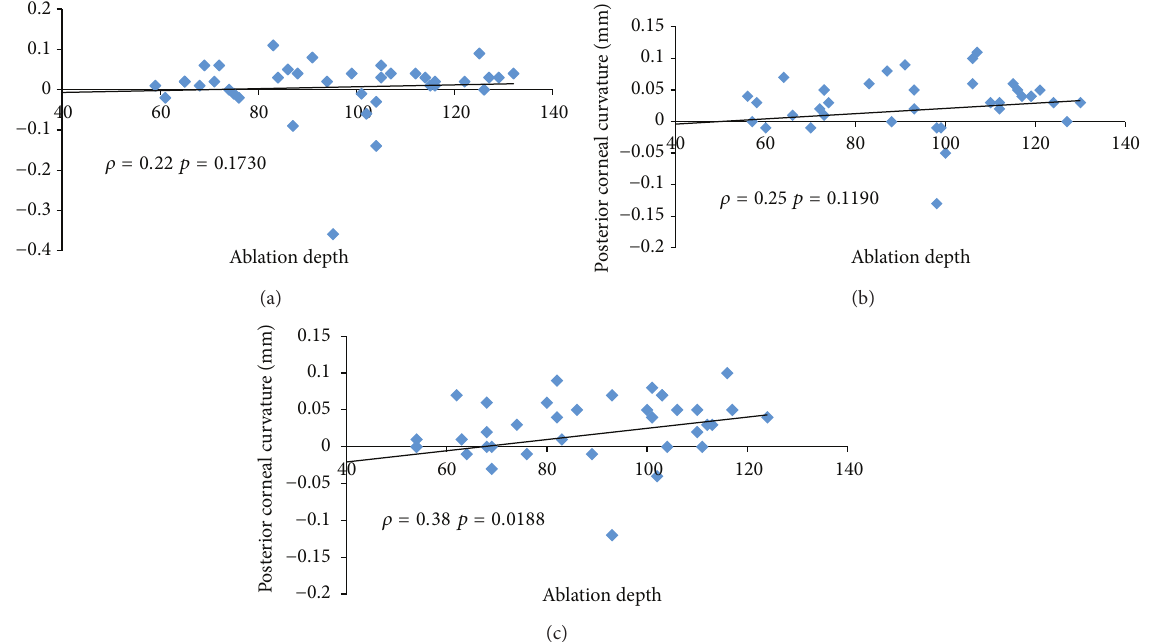
Figure 1: Spearman’s coefficient of rank correlation ( 𝜌 ) between corneal ablation depth and changes in posterior corneal curvature (mm) at 1 month (a), 6 months (b), and one year (c).